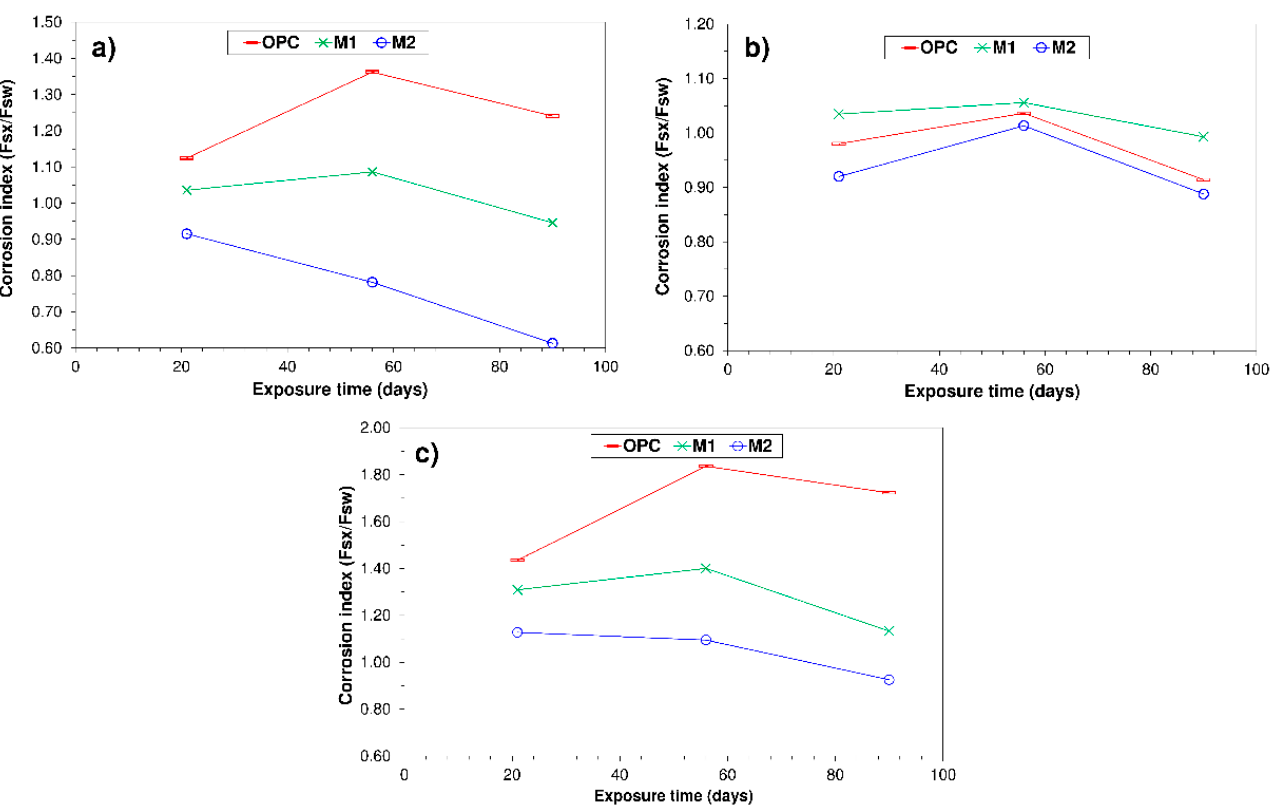
Figure 3. Corrosion indices over time in pastes OPC, M1 and M2 exposed to aggressive media: ( a ) seawater; ( b ) 0.5 M NaCl; ( c ) 0.3 M Na 2 SO 4 .